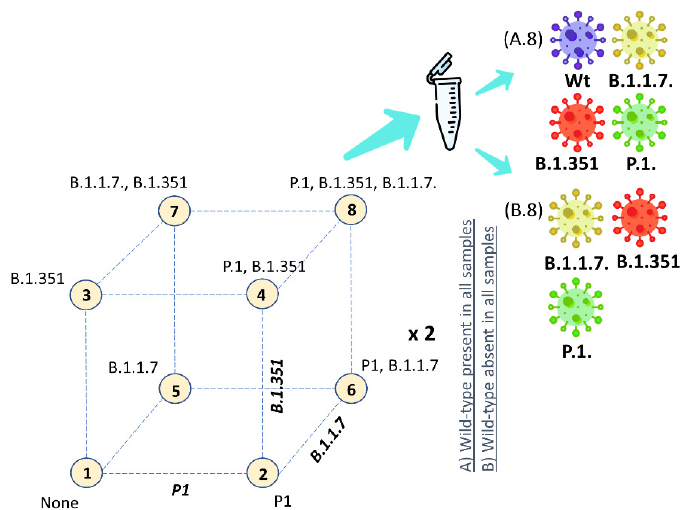
Figure 1. Design of experiment (DOE) for the preparation of the reaction mixtures containing different combinations of RNA of the variants of concern. Each corner of the cube represents a specific reaction mixture. The same DOE was applied with either ( A ) the Wuhan strain present in all samples or ( B ) the Wuhan strain absent in all samples.